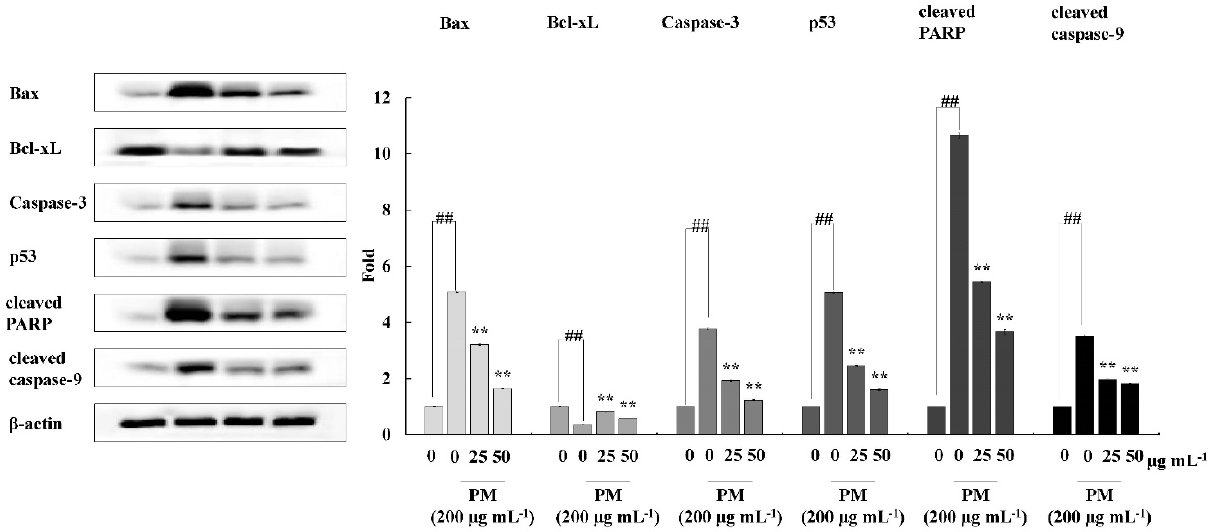
Figure 5. CRHF2 protects HaCaT keratinocytes from PM-stimulated apoptosis by inhibiting apoptotic proteins. Experiments were triplicated (n = 3). Results are represented as mean ± SD; ** p < 0.01. (# denotes significance compared to control while * represents significance compared to PM-treated group).